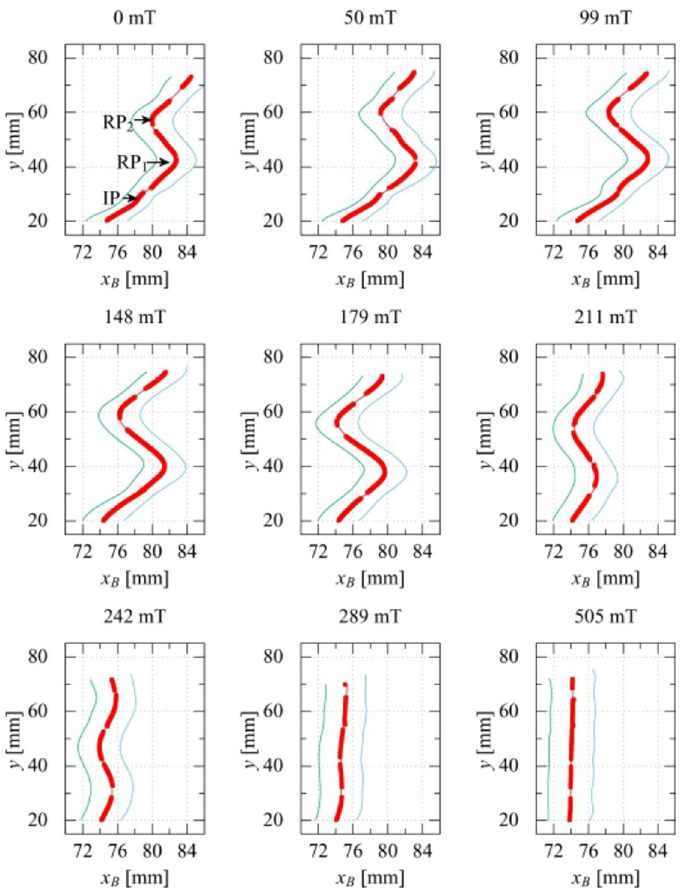
Figure 4. Comparison between numerically computed, and experimentally measured Ar bubble trajectories in Ga–In–Sn liquid metal, for various applied magnetic field